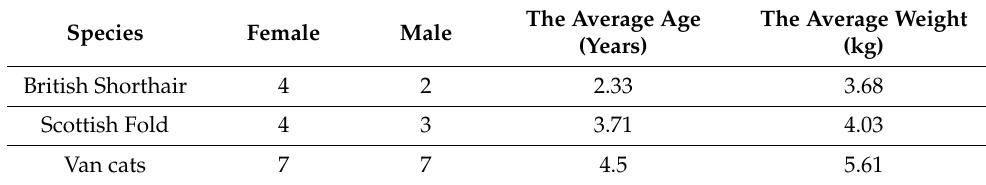
Table 1. Cats which were used in the